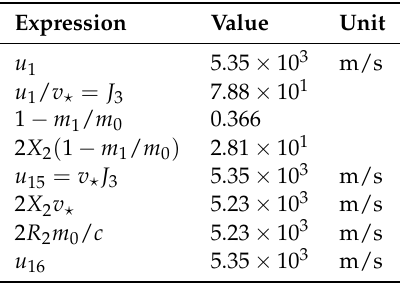
Table 3. Solution of TPBVP combining methods I and